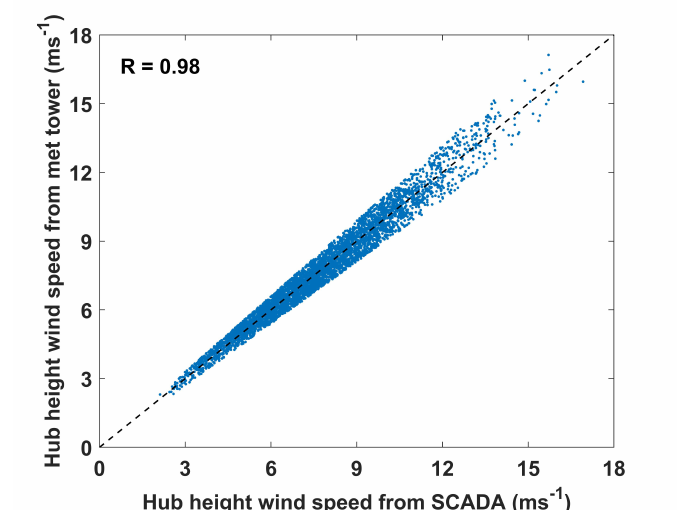
Figure 9. Comparison of ten-minute averaged hub-height wind speed measurements at the met tower and at the nacelle. The diagonal represents a 1:1